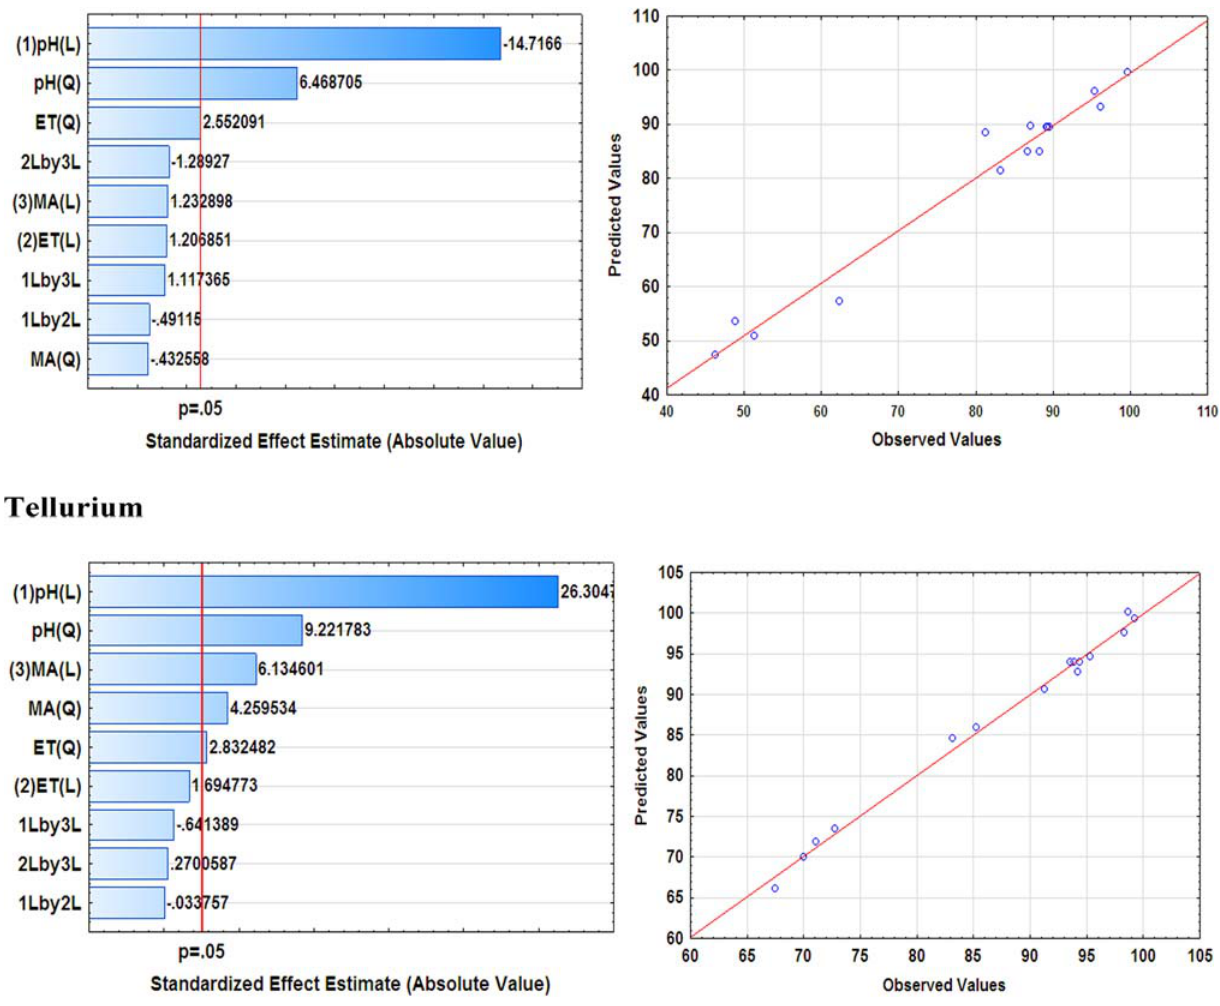
Figure 6: Pareto charts for standardized e ff ects and observed vs. predicted values for the preconcentration of Te and